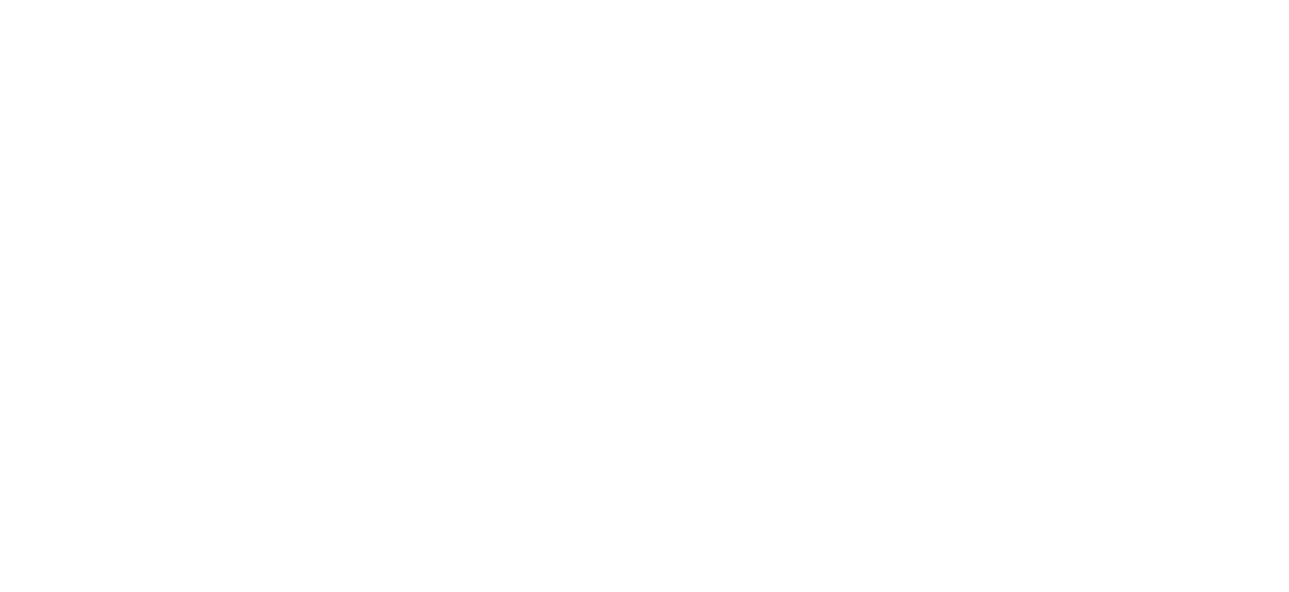
Frontiers in Pharmacology |